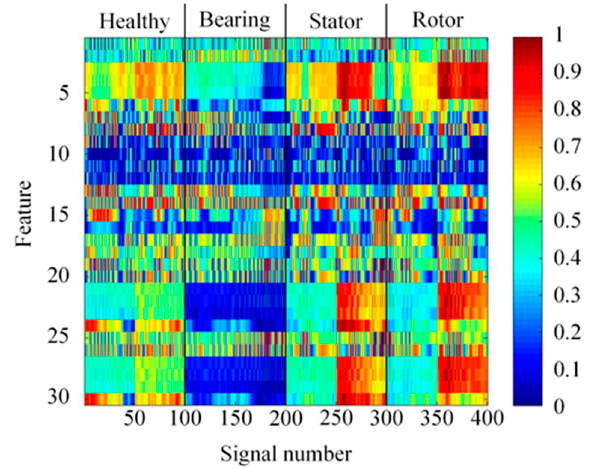
Figure 12. MRA feature energy diagram (signal noise ratio (SNR) = ∞ dB).